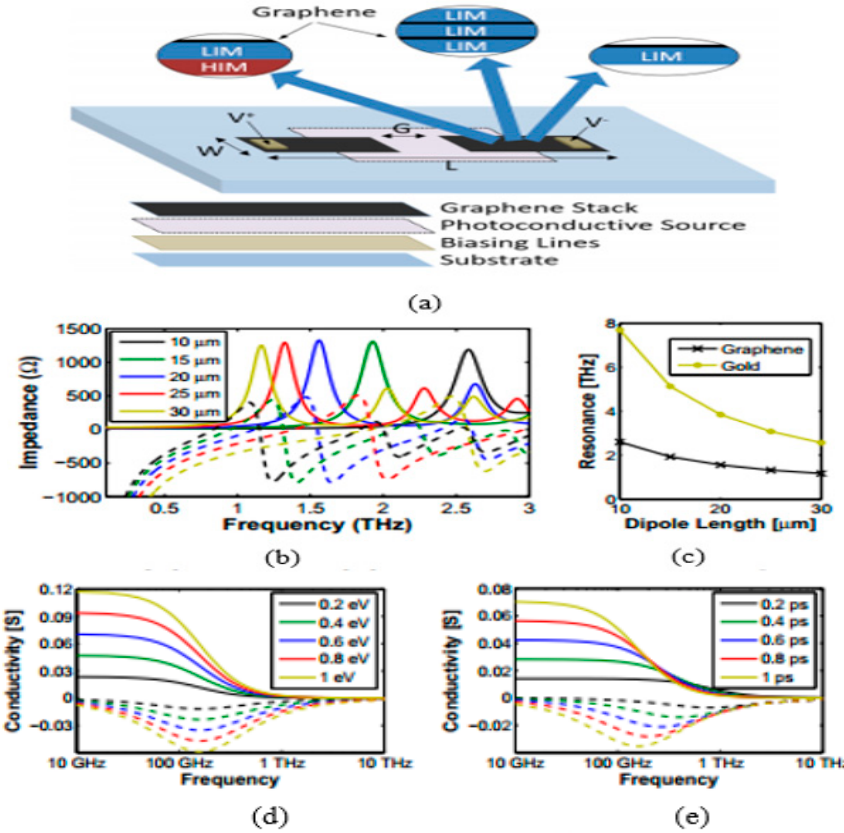
Figure 3. ( a ) Graphene stack dipole antenna on low index material (LIM); ( b ) input impedance and resonance frequency as a function of dipole arm length, where the frequency shifts to lower end as the length increases; ( c ) comparison of graphene radiator with gold, as gold radiator resonates at a higher frequency than graphene; and ( d , e ) behavior of conductivity with respect to changes in chemical potential and relaxation time. © IEEE 2017, Reprinted with permission from [102].